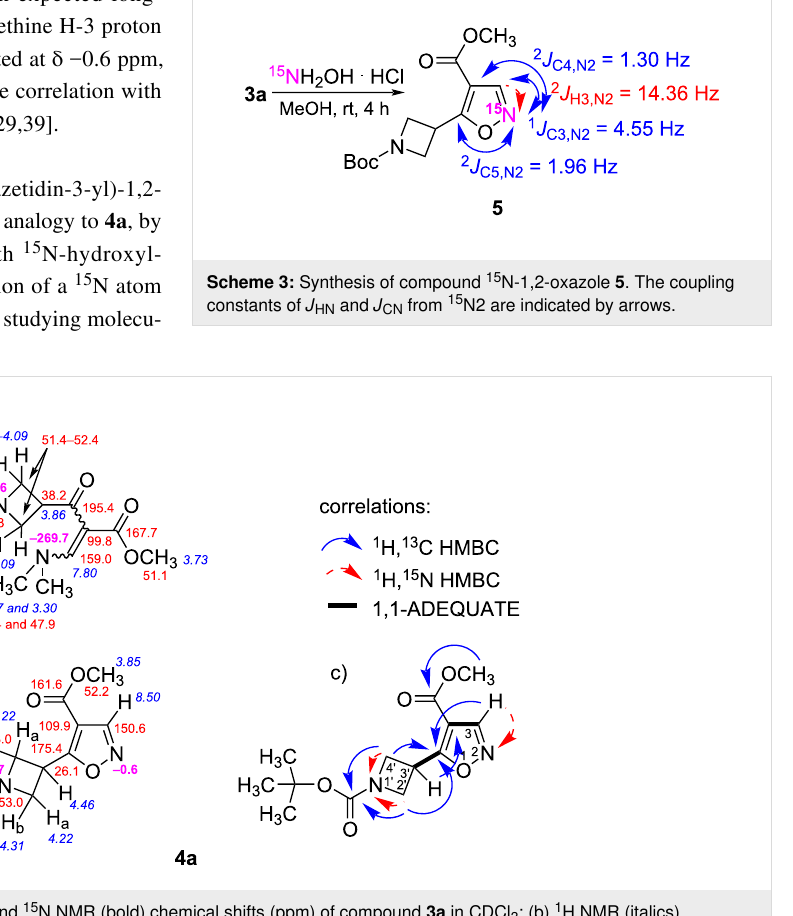
Figure 2: (a) 1 H NMR (italics), 13 C NMR (normal), and 15 N NMR (bold) chemical shifts (ppm) of compound 3a in CDCl 3 ; (b) 1 H NMR (italics), 13 C NMR (normal), and 15 N NMR (bold) chemical shifts (ppm) of compound 4a in CDCl 3 ; (c) relevant 1 H, 13 C HMBC, 1 H, 15 N HMBC and 1,1- ADEQUATE correlations of compound 4a